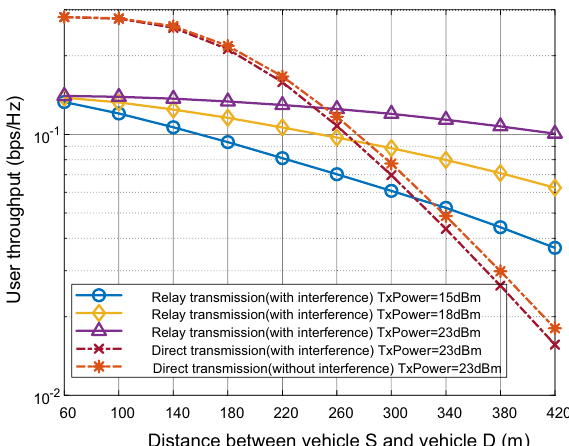
Fig. 17 Throughput performance with